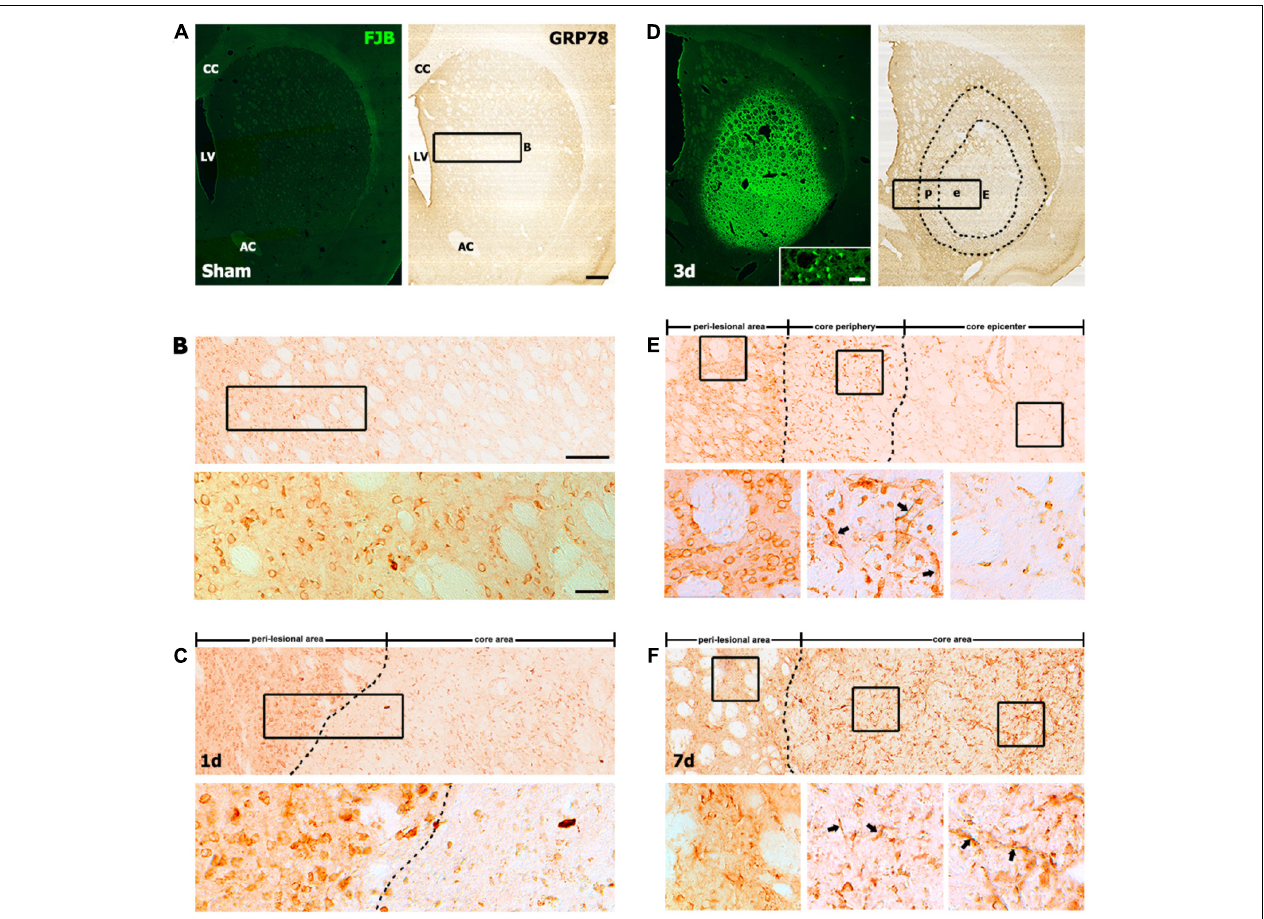
FIGURE 1 | Representative images showing the temporal expression of the 78-kDa glucose-regulated protein (GRP78) in striatal sections from saline-treated control and 3-nitropropionic acid-injected rats. (A,B) Lower- (A) and higher- (B) magnification views of coronal sections from saline-treated controls. (A) Serial striatal sections stained with Fluoro-Jade B (FJB) and anti-GRP78 antibody, showing no specific staining for FJB in the striatum. (B) Upper and lower panels of B are higher magnification images of the boxed area of A and upper panel of B, respectively, showing that GRP78 is present in neuron-like cells. (C) At day 1 after lesion induction, a spatial difference can be observed between GRP78 expression in the lesion core (right side of the broken line) and that in the peri-lesional area. The boxed area in upper panel is enlarged in the lower panel, showing that most neuronal profiles are absent in the lesion core, while intense GRP78 immunoreactivity is still evident in neurons in the peri-lesional area. (D) At 3 days after lesion induction, the core of the lesion, which is clearly distinguished by intense FJB staining, can be divided into two distinct areas on the basis of GRP78 immunoreactivity: the epicenter (e) and the lesion periphery (p); the border between these areas is indicated by the broken line. (Inset in left panel of D ) Higher magnification image of an FJB-stained section, showing intense FJB staining within neuronal profiles in the lesion core. ( E , Upper) Higher magnification image of the boxed area of D , showing the distinct expression patterns of GRP78 in the perilesional area, lesion periphery, and epicenter. Boxed areas in these three parts are enlarged in the corresponding lower panels of E . ( E , Lower) Intense GRP78 expression is observed in vascular profiles (arrows in middle panel) and cells with round cell bodies in the lesion periphery, while no prominent GRP78 expression is visible in the lesion epicenter. ( F , Upper) At day 7 after lesion induction, GRP78 expression is more densely distributed throughout the lesion core (right side of the broken line). ( F , Lower) Higher magnification images of boxed areas in the three areas, i.e., the perilesional area, lesion periphery, and epicenter, from the corresponding images in the upper panel. Note that vessel-associated GRP78 immunoreactivity is evident in both the lesion periphery (arrows in middle panel) and the epicenter (arrows in right panel). CC, corpus callosum; LV, lateral ventricle; AC, anterior commissure. Scale bars represent 500 µ m for A , D ; 200 µ m for upper panels in B , C , E , F ; and 50 µ m for the inset in the left panel in D and lower panels in B , C , E , F